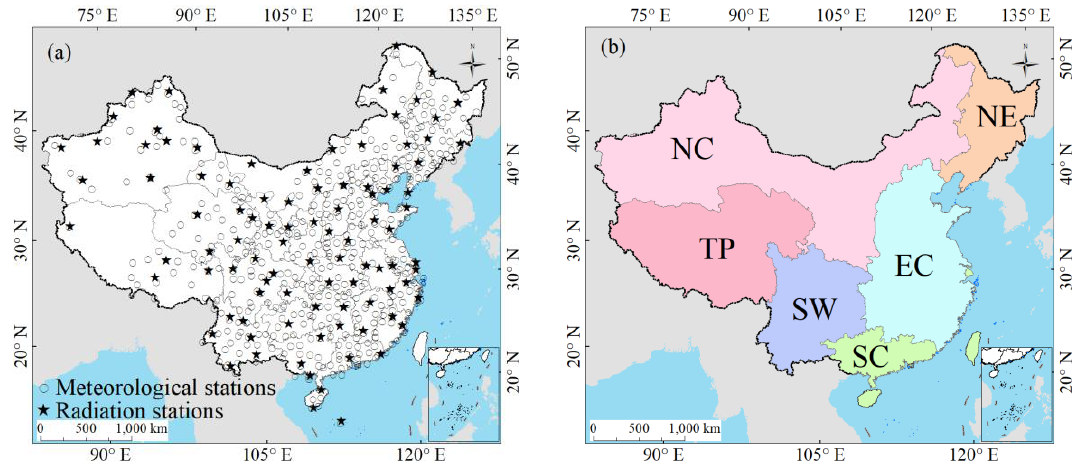
Figure 1. ( a ) The spatial distribution of 454 Climate Data Centers of the Chinese Meteorological Administration (CDC / CMA) stations, the 96 radiation stations are denoted by five-pointed star symbols, ( b ) six climatic regions of China.